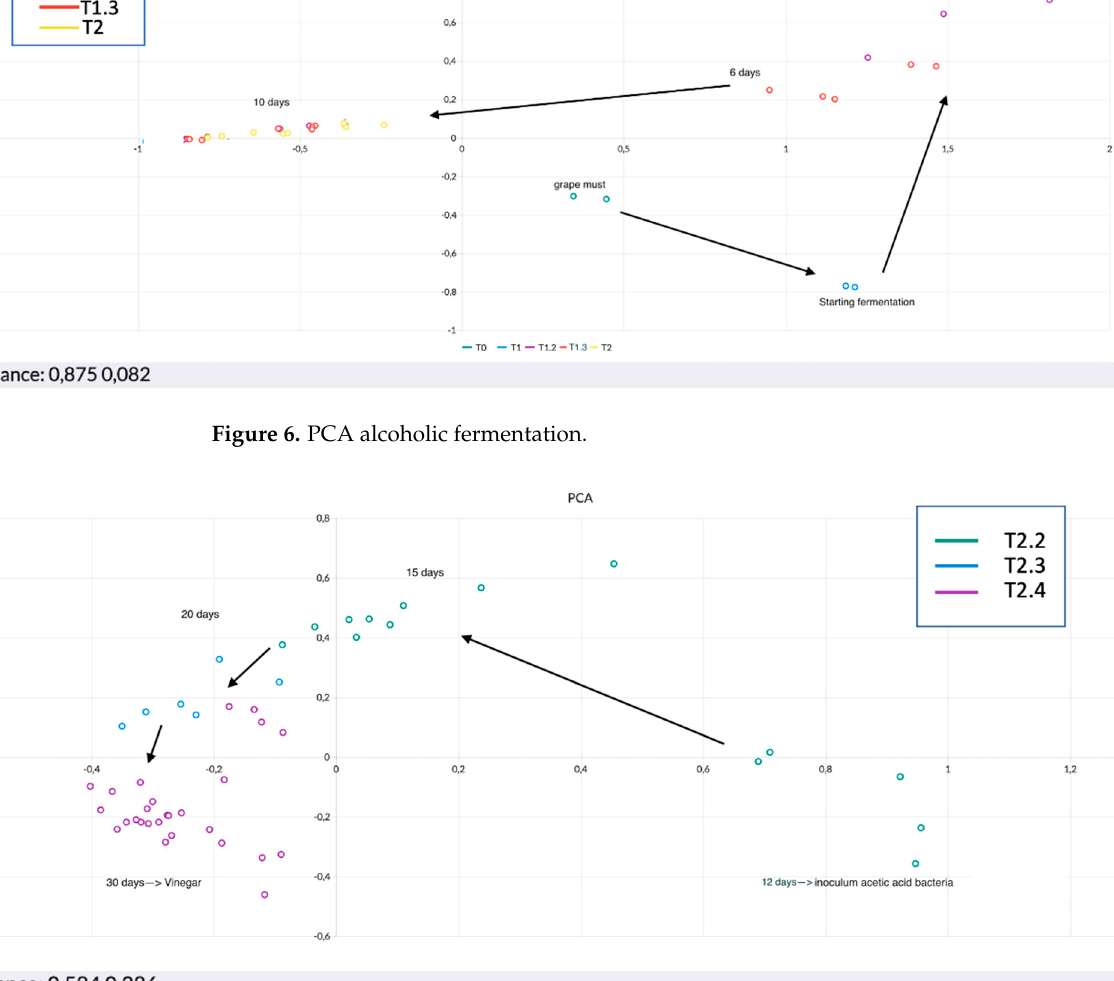
Figure 7. PCA acetic fermentation.